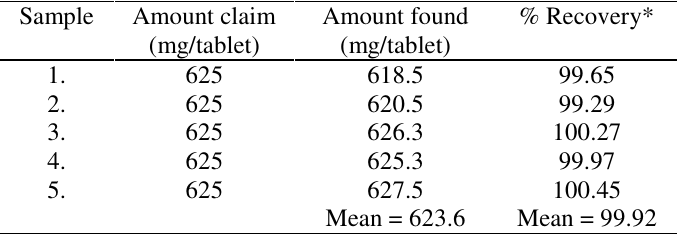
Table 2. Results of HPLC assay and Recovery studies